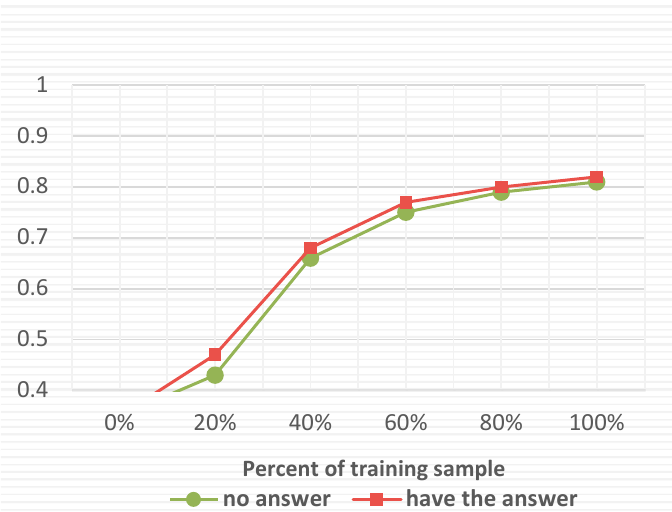
Figure 6. Comparison of the YAHOO dataset.